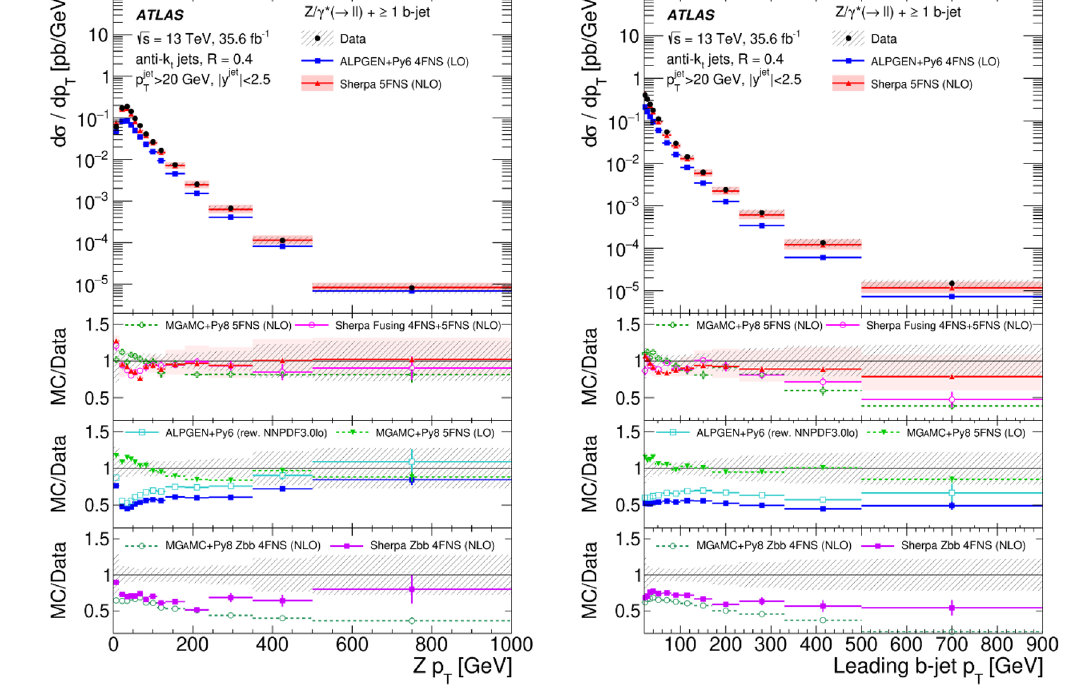
Figure 8 . Measured cross-section as a function of Z -boson p T (left) and leading b -jet p T (right) in events with at least one b -jet. The data are compared with the predictions from Sherpa 5FNS (NLO) , Alpgen + Py6 4 FNS (LO) , Sherpa Fusing 4FNS+5FNS (NLO) , Sherpa Zbb 4FNS (NLO) , MGaMC + Py8 5FNS (LO) , MGaMC + Py8 Zbb 4FNS (NLO) and MGaMC + Py8 5FNS (NLO) . The error bars correspond to the statistical uncertainty, and the hatched bands to the data statistical and systematic uncertainties added in quadrature. The red band corresponds to the statistical and theoretical uncertainties of Sherpa 5FNS (NLO) added in quadrature. Only statistical uncertainties are shown for the other